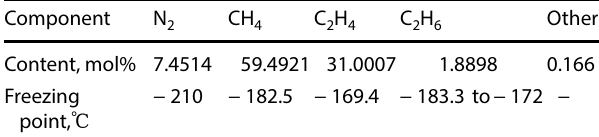
Table 1 Working condition data of measuring points